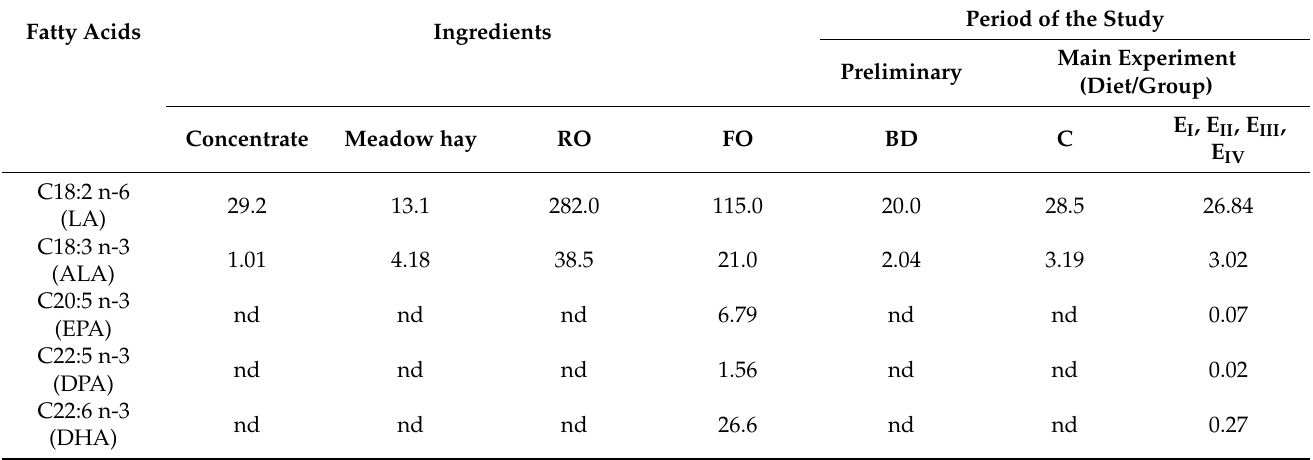
Table 3. Long-chain fatty acid concentration (g/kg) in the ingredients and diets fed to